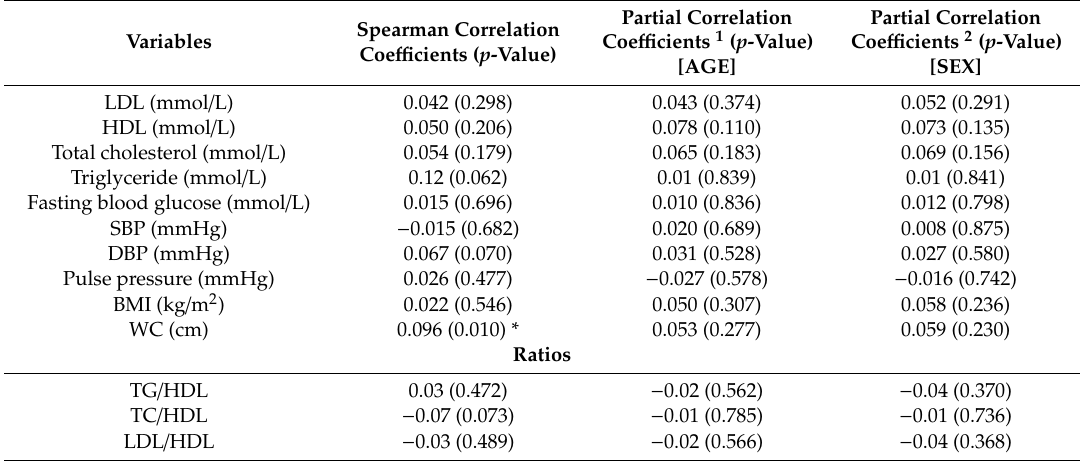
Table 2. Correlation (Spearman and partial) between low 25(OH)D and cardio-metabolic risk factors. Variables